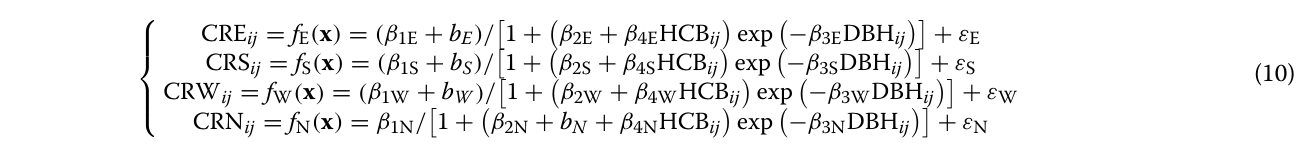
Tables 4 and 5 report the estimated fixed parame- ters and random effects variance-covariance matrix of NSURMEM, respectively. All the fixed parameters were statistically significant at P 0.05 with negative or pos- = itive biological significance.